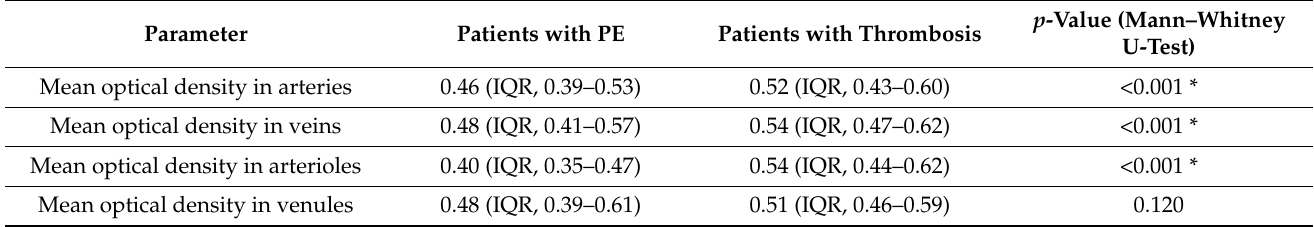
Table 4. Comparative intergroup analysis of mean optical density in vascular endothelium in the groups of patients with PE and thrombosis.